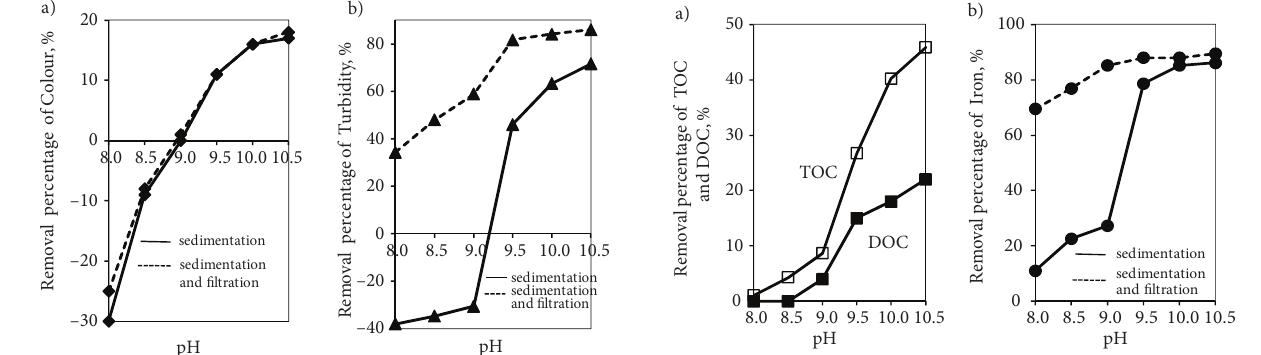
Figure 1. Influence of pH on the efficiency of reduction of colour (a) and turbidity (b) in the process of Ca(OH) 2 alkalinisation and two-hour sedimentation